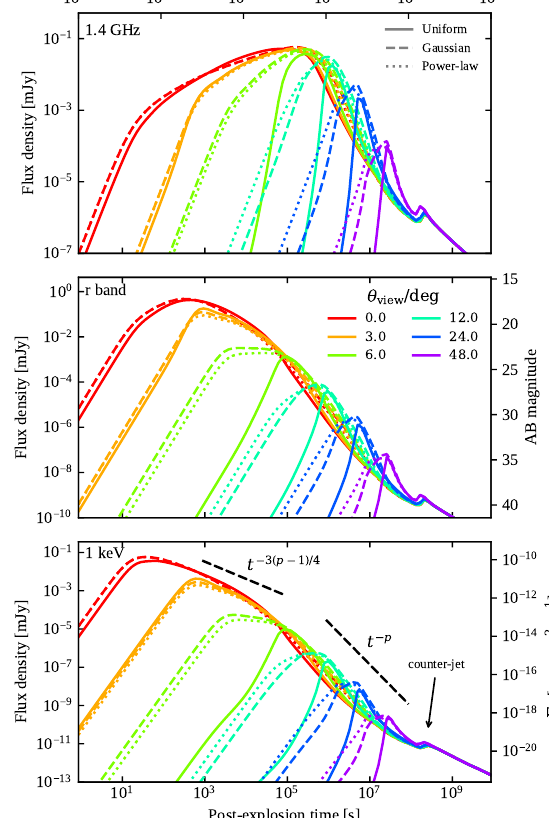
Figure 10. Example synthetic afterglow light curves for jets at z = 1 with differing structures, seen under various viewing angles (color-coded as reported in the legend), computed within the “standard afterglow” model described in Section 4.2 assuming (cid:101) e = 0.1, (cid:101) B = 10 − 3 , p = 2.2, and a homogeneous external medium with number density n = 0.1cm − 3 . Each structure can be defined as d E /d Ω = ( E c /4 π ) f ( θ / θ c ) and Γ = 1 + ( Γ c − 1 ) f ( θ / θ c ) : (i) the Uniform structure (solid lines) has f ( x ) = Θ ( 1 − x ) , where Θ ( x ) is the Heaviside step function; (ii) Gaussian jet (dashed lines), with f ( x ) = exp ( − x 2 /2 ) ; (iii) Power-law jet, with f ( x ) = ( 1 + x 3 ) − 1 . For all jets, E c = 10 53 erg, Γ c = 300 and θ c = 3 ◦ . Each panel shows light curves computed at a different observing frequency: 1.4 GHz (top panel), r-band (i.e., 4.6 × 10 14 Hz, central panel) and 1 keV (i.e., 2.4 × 10 17 Hz, bottom panel). In the bottom panel, we show for comparison the slopes expected for the X-ray (mostly also valid for the Optical) post-peak (for viewing angles close to the jet axis) and post-jet-break light curves. The late-time peak produced by the emission of the counter-jet is also